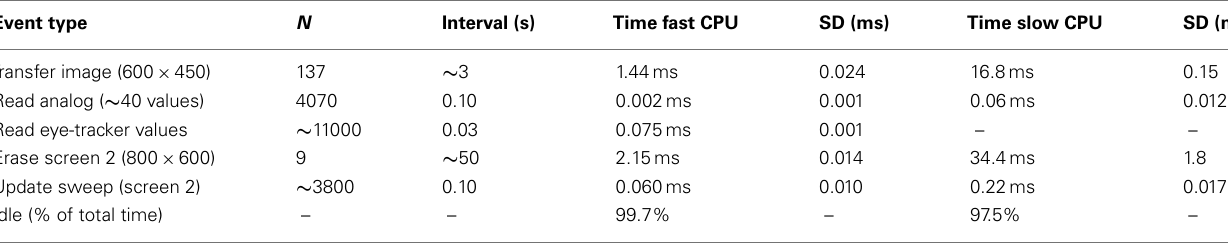
Table 1 |Average duration of real-time I/O events during ObjWM